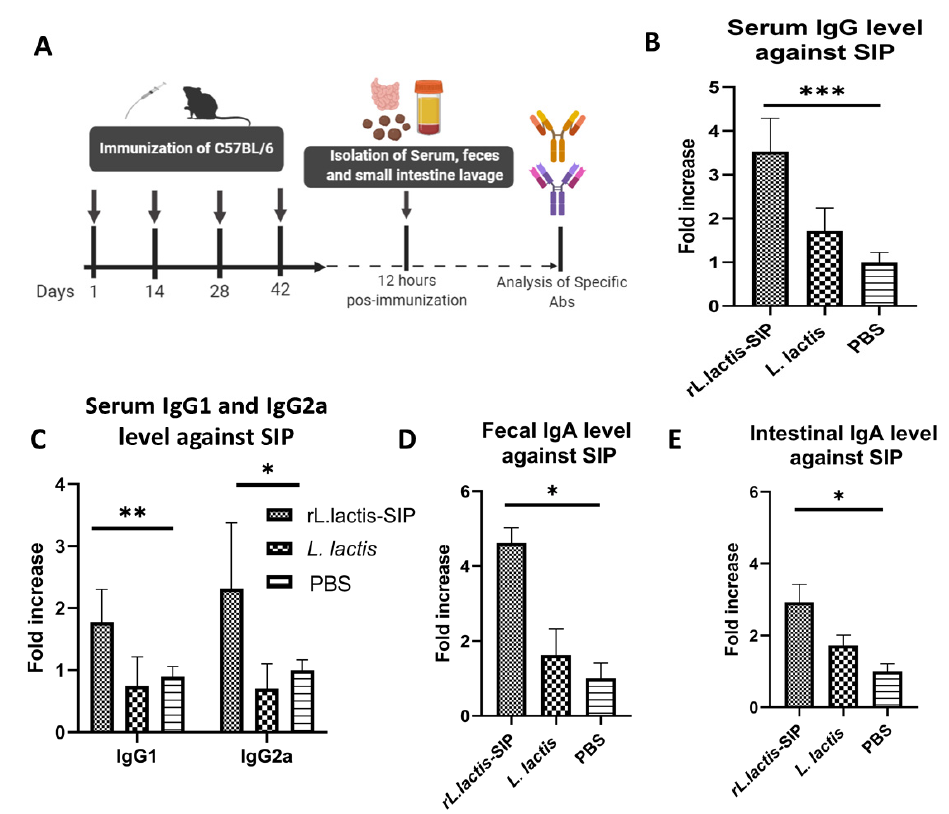
Figure 2. Oral immunization induced with rL. lactis -SIP generated systemic and mucosal anti-SIP immunoglobulin G (IgG) and immunoglobulin A (IgA). ( A ) Representation of the immunization used in C57BL/6 mice experiment. The mice (per group) were orally immunized four times with 1x10 10 CFU of rL. lactis -SIP at intervals of 14 days. The mice in the control groups were immunized with 1x10 10 CFU of L. lactis or PBS. The secretion of specific immunoglobulins against SIP was measured by ELISA from the sera collected from mice immunized without GBS colonization. Serum anti-SIP: ( B ) IgG, ( C ) IgG1 and IgG2a, ( D ) IgA from feces, and ( E ) intestinal IgA production were determined with respect to the PBS-immunized mice (control). Results represent one of two independent experiments with similar results. The bars indicate the mean ± standard deviation of immunoglobulins. *** p < 0.0001; ** p < 0.001; * p < 0.05 by multiple-comparison ANOVA for rL. lactis -SIP immunized mice compared with PBS-immunized mice.